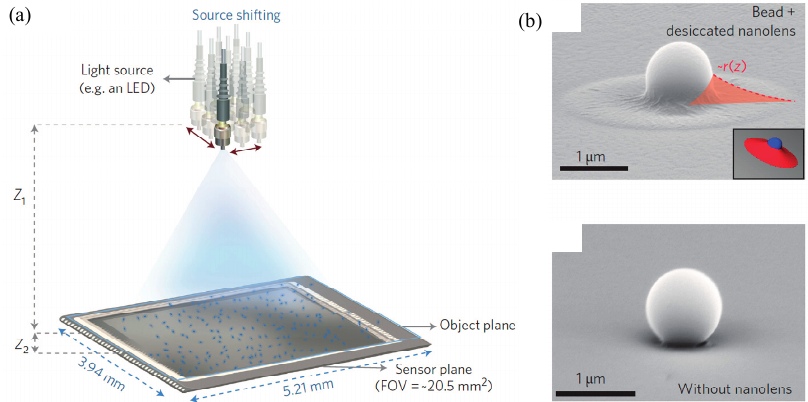
Figure 13. ( a ) Schematic image of on-chip lensless microscopy with nanolenses. The distance from light source to sample is 8–12 cm and the light source can move 300 μ m along the plane which could cover area of ~20.5 mm 2 ( b ) SEM image of nanolenses with (top) and without (bottom) nanolense (Reproduced with permission from